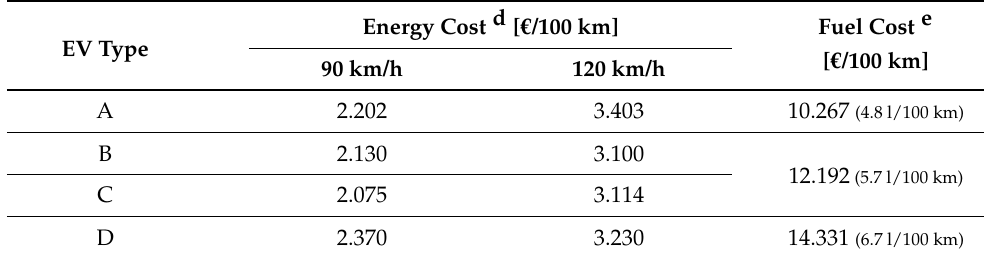
Table 3. Energy consumption costs.